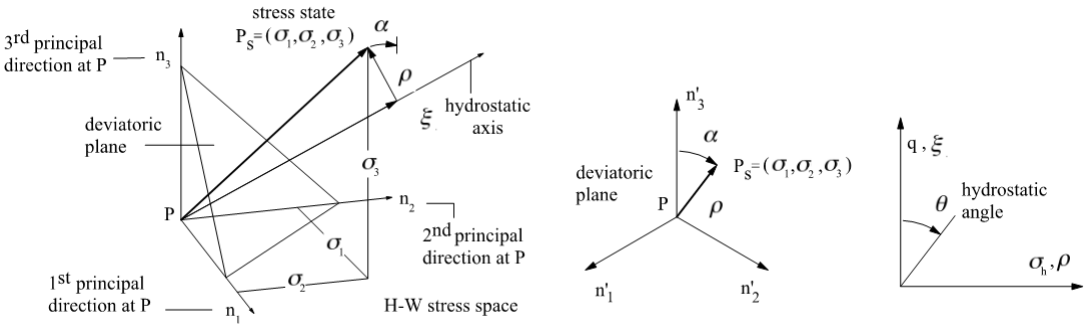
Fig. 2 Representation of stress state at P in the three-dimensional Haigh-Westergaard stress space, in an orthogonal ( x,y,z ) and a cylindrical (  ) reference